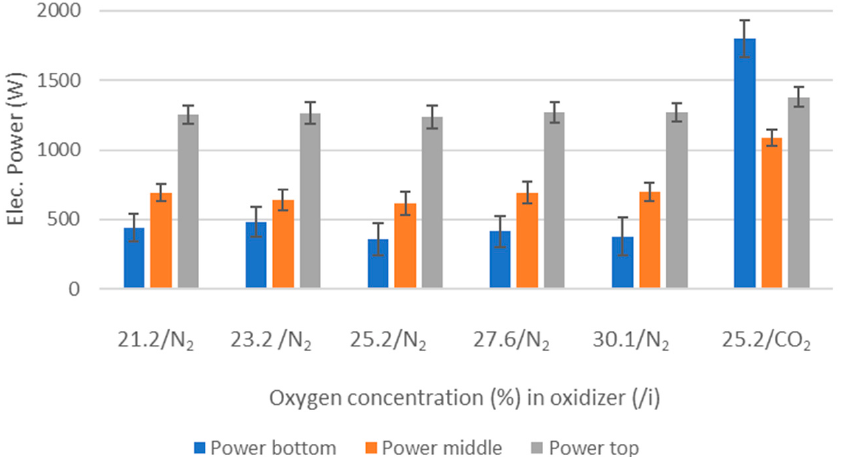
Figure 3. Temperatures at different O 2 input concentrations, O 2 /N 2 input mixes, total oxidizer flow rate in: 160 NL/min (except 30.1 case, 150 NL/min). “T+number” indicates the location of the ther- mocouple above the grate in mm (see also Figure 1).